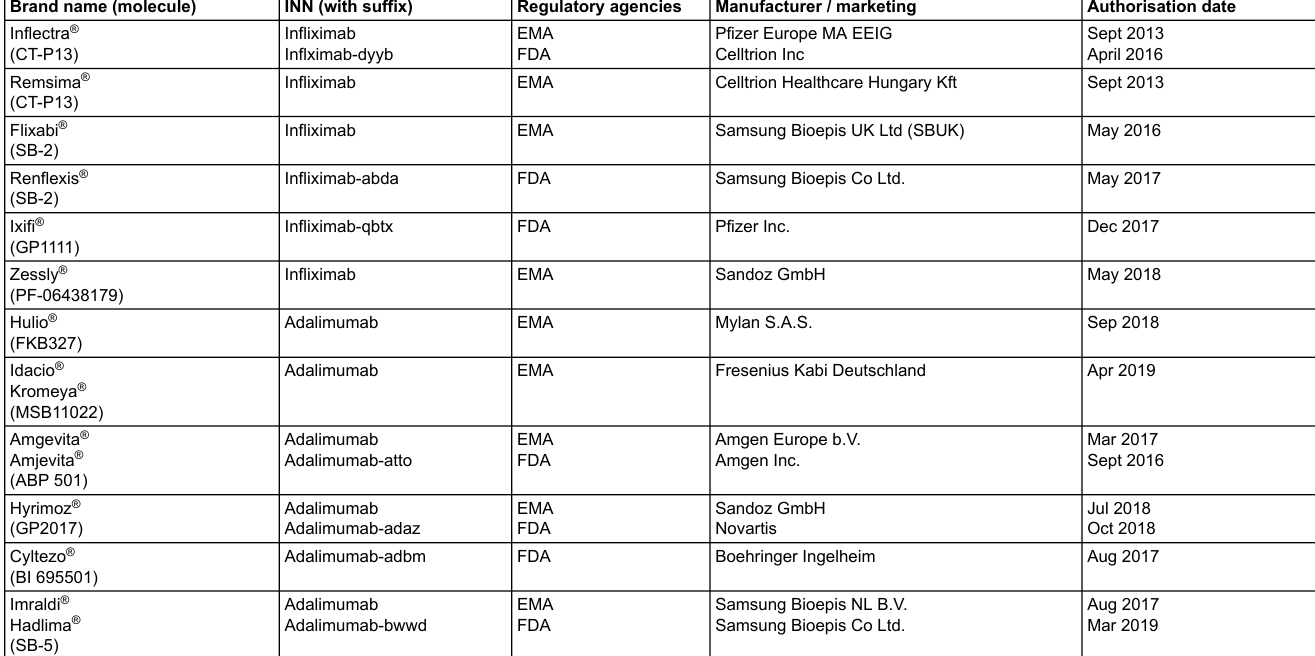
Table 1: Biosimilars approved by the EMA and/or FDA.